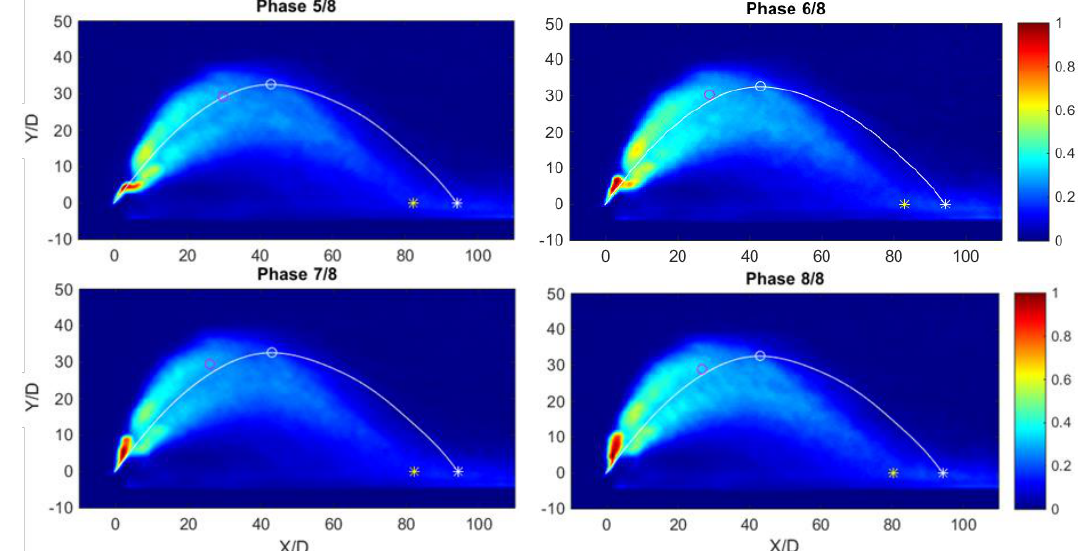
Figure 6. Non-dimensional mean concentration fields for the same NBJ of Figure 3, divided into 8 phases; the white line is the stagnant case jet axis; the maximum uncertainty in the mean concentration measurement is ±4.38%.